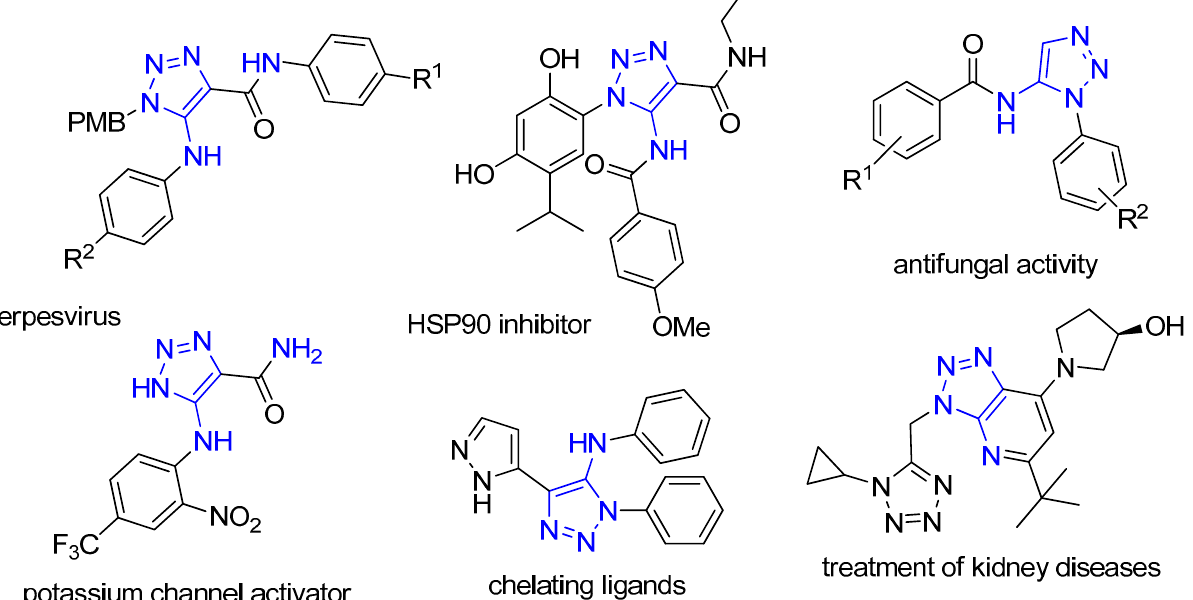
Molecules 2022 , 27 , x FOR PEER REVIEW